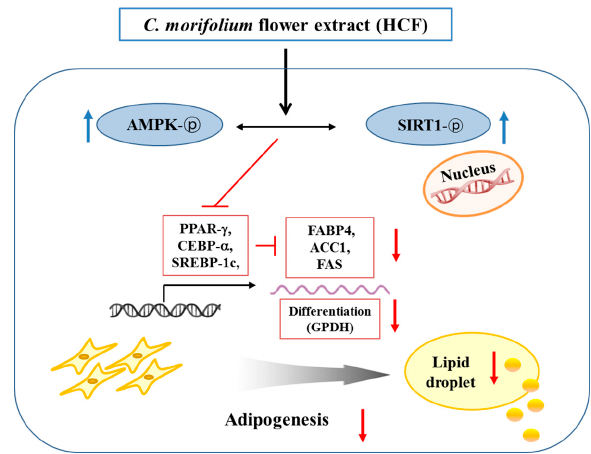
Figure 7. Schematic diagram showing potential regulatory mechanisms in adipogenesis by HCF in 3T3-L1 adipocytes.